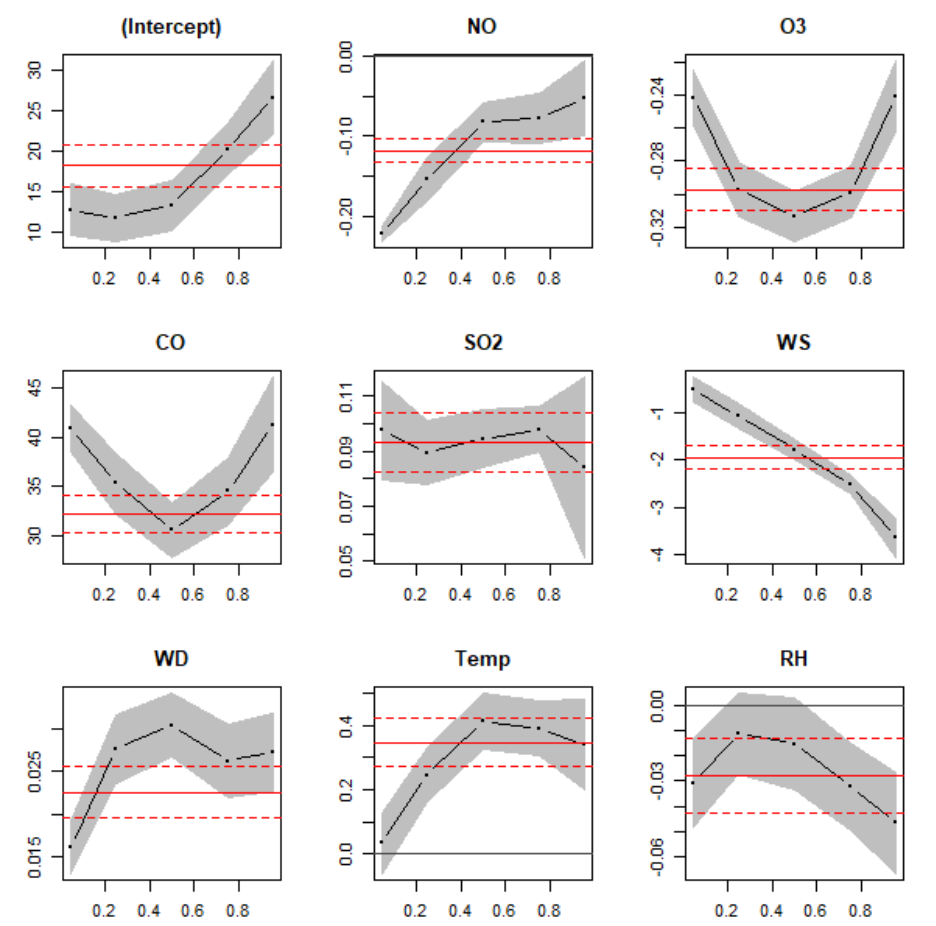
Figure 6. Outputs of quantile regression model analyzing NO 2 concentrations (ppb) using several